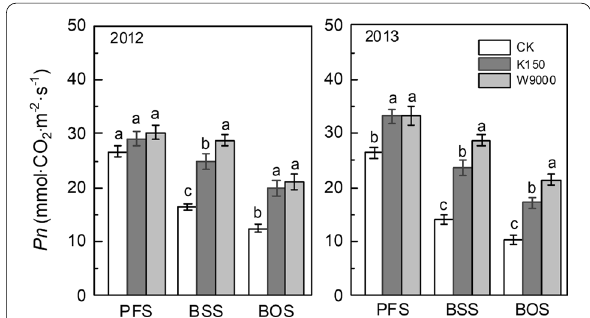
Fig. 2 Effects of straw-returning and inorganic K fertilizer on the net photosynthetic rate ( Pn ) of the functional leaf at the peak flowering (PFS), boll-setting (BSS) and boll-opening (BOS) stages of Siza 3 in 2012 and 2013. The data are means of three replications standard ± error. For each growth stage, bars bearing different letters are significantly different at P 0.05 =